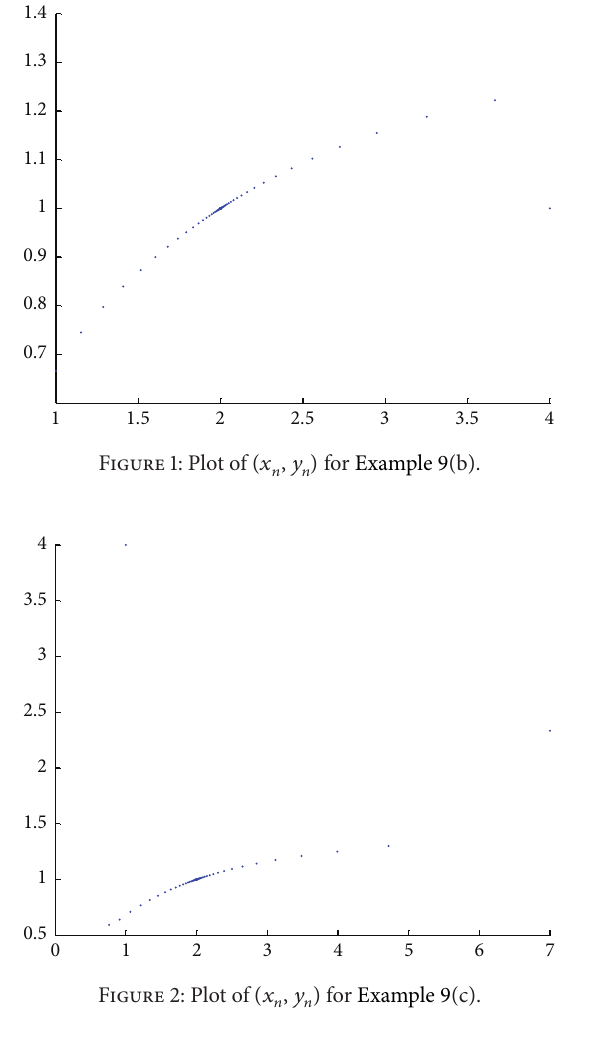
Figure 2: Plot of (𝑥 𝑛 ,𝑦 𝑛 ) for Example